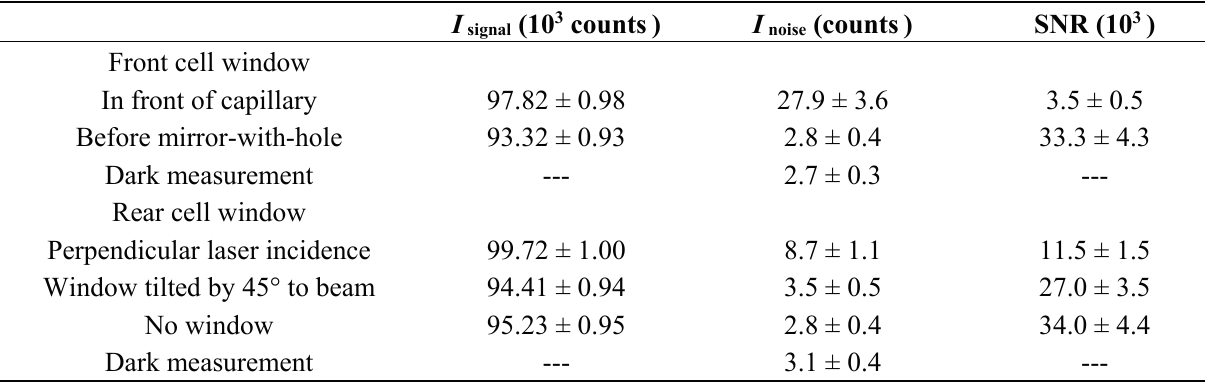
Table 3. Influence of the front and rear cell windows (position and orientation) on the fluorescence